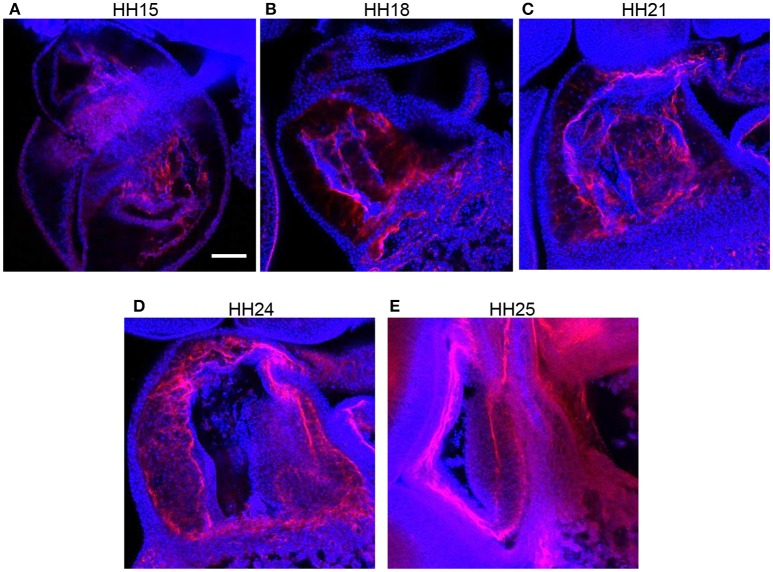
Normal periostin expression in outflow tract cushions. Confocal fluorescent images at 20x from whole embryo hearts labeled with periostin (red) and DAPI (blue) at progressing developmental stages, (A) HH15, (B) HH18, (C) HH21, (D) HH24, and (E) HH25. Scale bar = 100 microns.